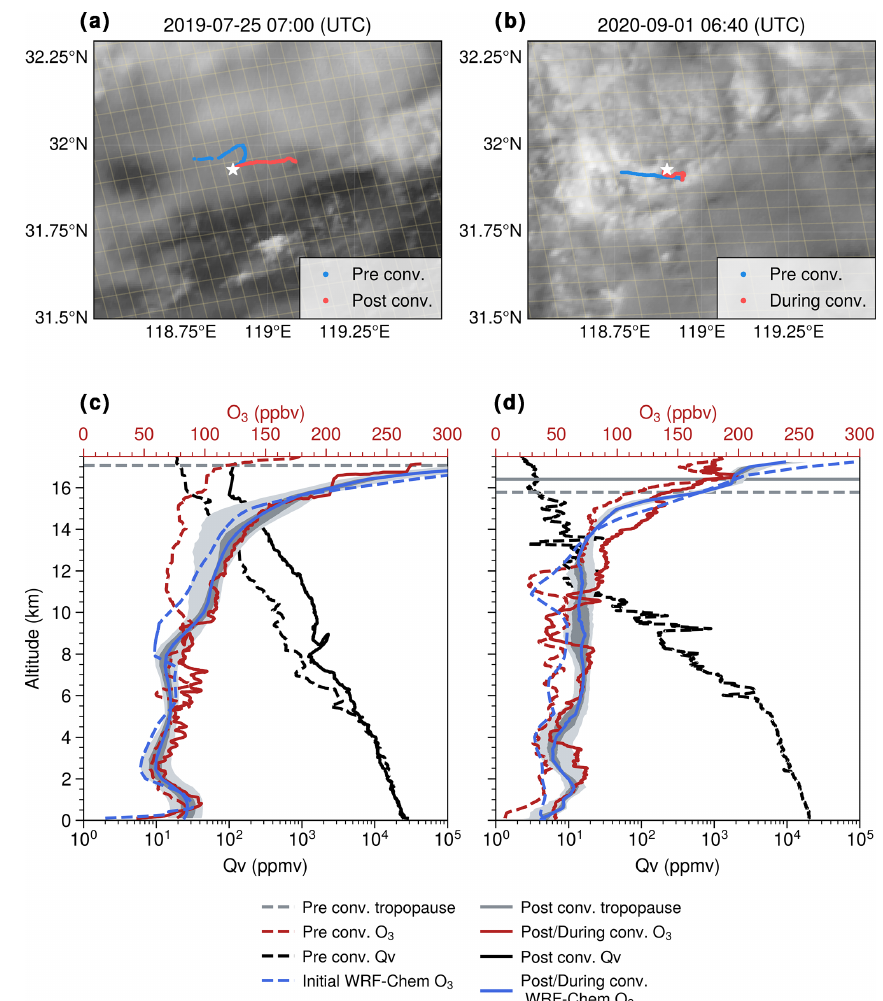
Figure 1. (a, b) The convection detected by the FY-4A Advanced Geostationary Radiation Imager (AGRI) visible channel (0.65µm) field at the time when the post-convection/during-convection ozonesondes reached around 10km. The pre-convection ozonesonde trajectories are colored blue, while the others are in red. The white star symbol stands for the observation station, and the thin yellow lines are the TROPOMI swath pixels. Panels (c) and (d) are the observed O 3 (red) and Qv (black) profiles in the pre-convection (dashed) and post-convection/during- convection (solid) periods. The initial (dashed) and simulated post-convection or during-convection (solid) O 3 profiles are in blue. The dark gray shading is the 50% confidence interval, while the light one is the 90% confidence interval. The gray lines are the lapse rate